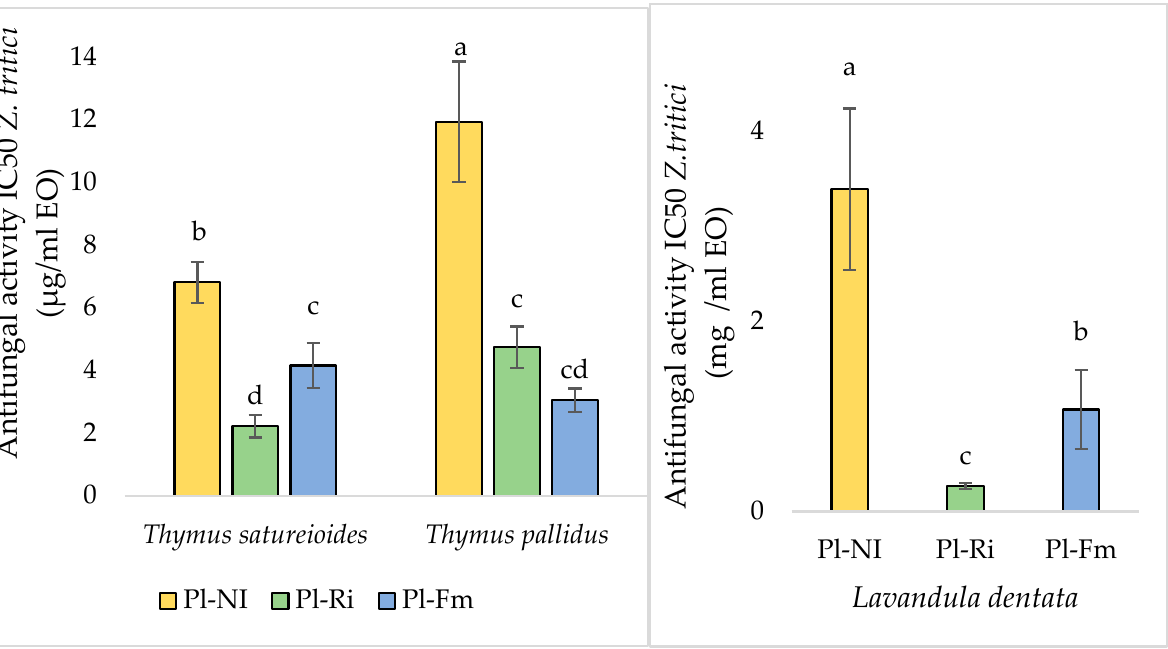
Figure 10. Antifungal activity IC 50 of essential oil of Thymus satureioides (Ts), Thymus pallidus (Tp), and Lavandula dentata (Ld), non-inoculated (NI) or inoculated with Rhizophagus irregularis (Ri) or Funneliformis mosseae (Fm) after 4 months of culture under greenhouse conditions Bars followed by the same letter are not significantly different according to Tukey’s HSD test ( p < 0.05).